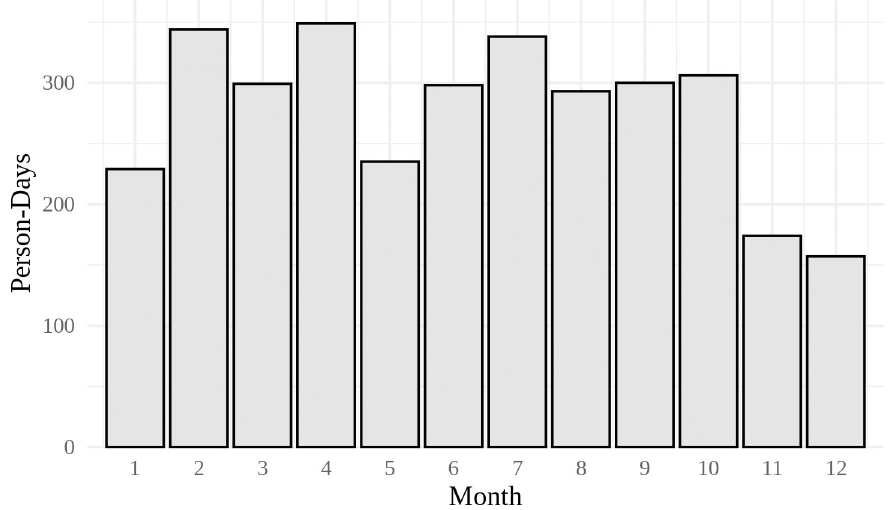
Fig 1. Histogram of accelerometer data collected by month of the year, in person-days (n = 3322).